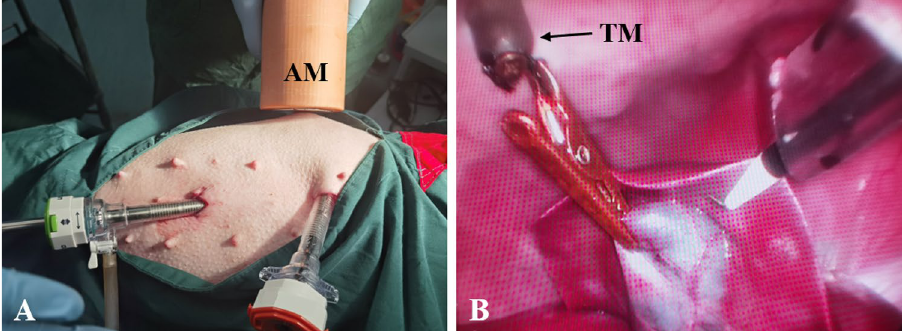
Figure 3. Intraoperative photographs showing the use of the magnetic anchor device. (A) Abdominal wall port and anchor magnet. (B) State of the internal grasper pulling the